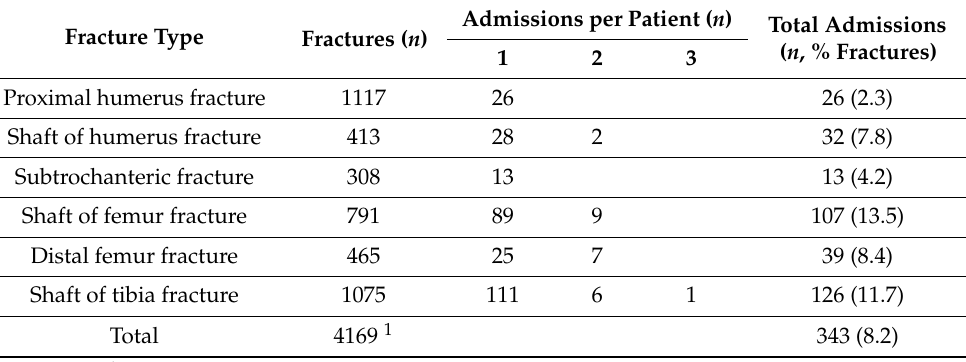
Table 2. Fracture healing complication admissions within two years of index fracture—by fracture type ( n = 3886 patients).